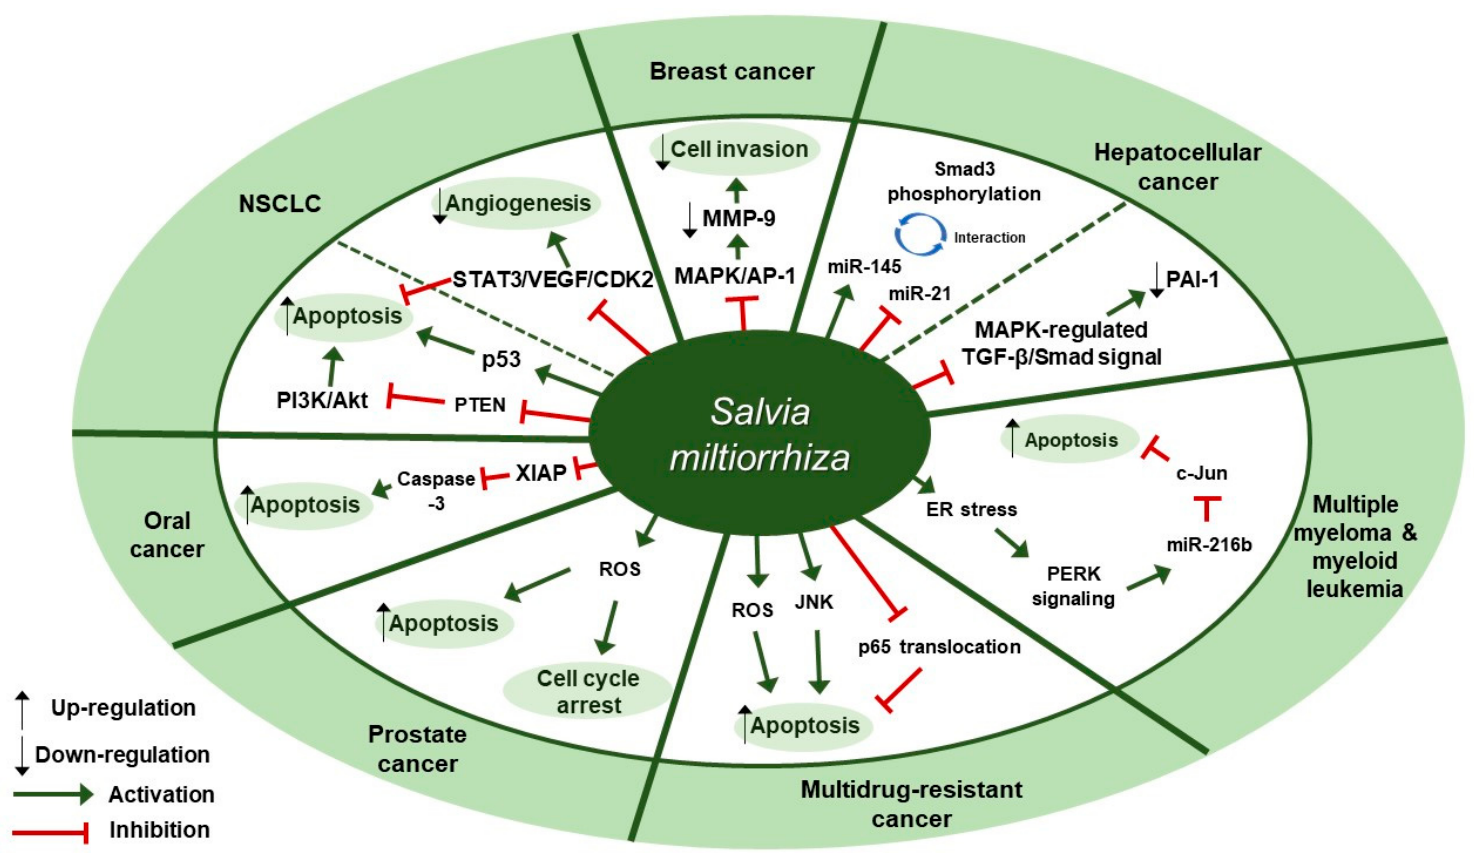
Figure 1. Therapeutic targets of S. miltiorrhiza in cancers. NSCLC, non-small cell lung cancer; MAPK, mitogen-activated protein kinase; AP-1, activator protein-1; MMP-9, matrix metalloproteinase-9; miR-145, microRNA-145; miR-21, microRNA-21; PAI-1, plasminogen activator inhibitor 1; ER, endoplasmic reticulum; PERK, protein kinase RNA-like endoplasmic reticulum kinase; miR-216b, microRNA-216b; JNK, c-Jun N-terminal kinase; ROS, reactive oxygen species; XIAP, X-linked inhibitor of apoptosis protein; PTEN, phosphatase and tensin homolog deleted on chromosome ten; PI3K, phosphoinositide 3-kinase; NSCLC, non-small cell lung cancer; STAT3, signal transducer and activator of transcription 3; VEGF, vascular endothelial growth factor; CDK2, cyclin-dependent kinase 2.